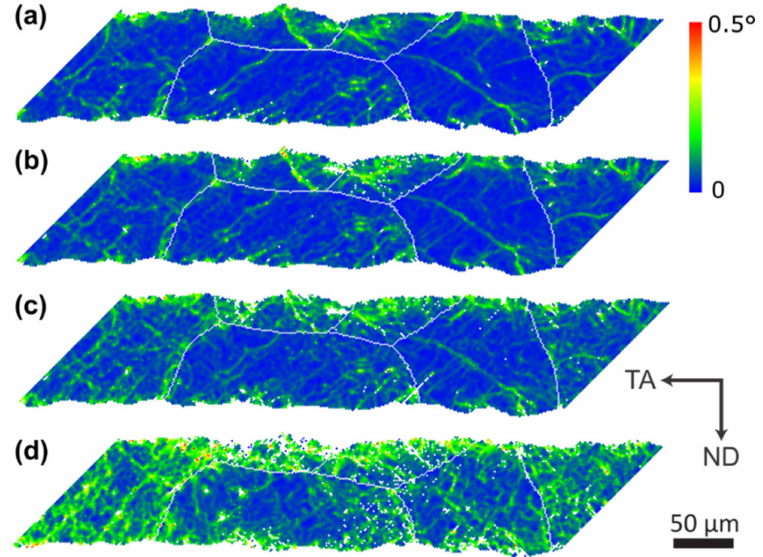
Figure 3. Local misorientation angle maps for the six Al grains at different tensile strains. ( a ) 0.23%; ( b ) 0.45%; ( c ) 0.83%; ( d )